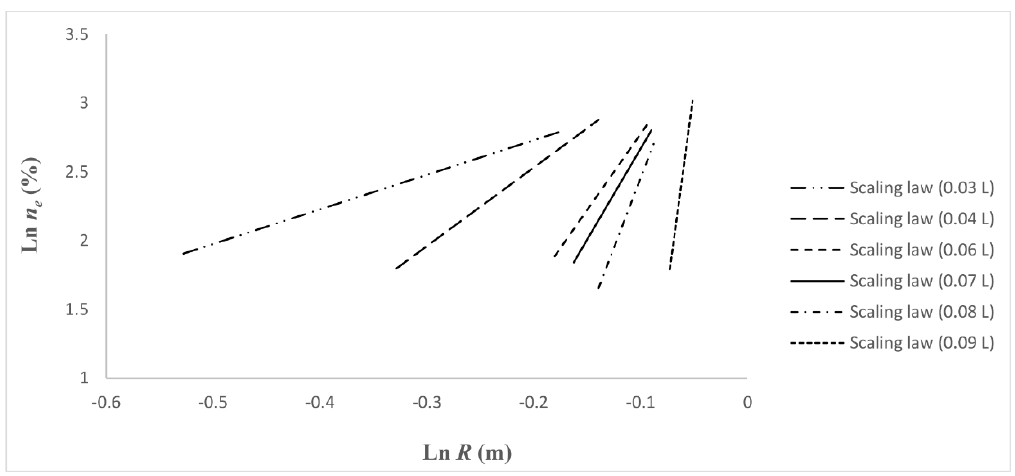
Figure 5. Scaling laws n e = n e ( R ) for each injection volume considered.